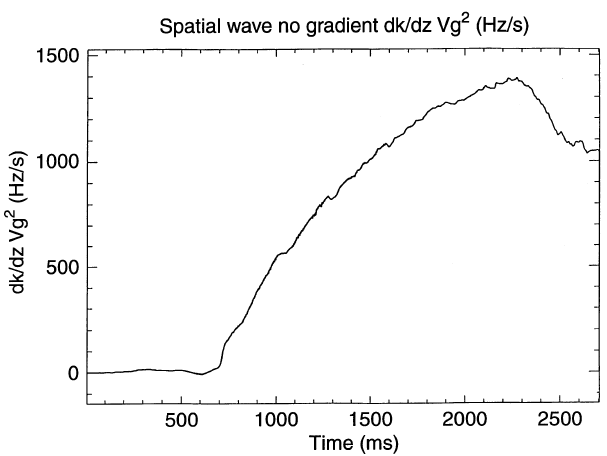
Fig. 7. Case A. Plot of spatially averaged wave number gradient across the simulation box, as a function of time. The quantity plotted is ( ) d k /d z . Vg 2 ) (Hz/s). The final value of +1400 Hz/s indicates that spatial wave number gradients are a dominant cause of frequency